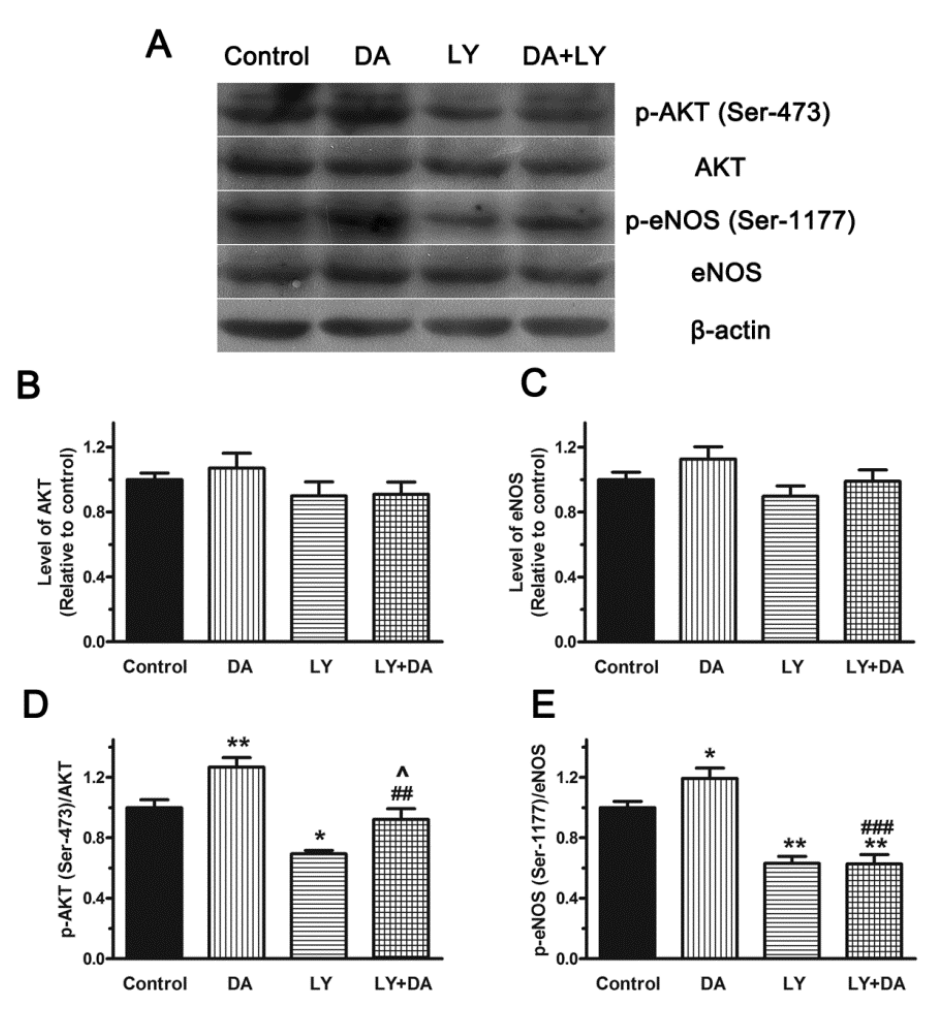
Figure 8. Role of the PI3K/Akt Pathway in DA -induced phosphorylation of AKT and eNOS in PAECs. PAECs were incubated with vehicle (DMSO), DA (20 μ M), LY294002 (LY, 10 − 6 M) and DA (20 μ M) plus LY (10 − 6 M) for 10 min. Then the levels of p-Akt (Ser-473), Akt, p-eNOS (Ser-1177) and eNOS ( A ) were determined by Western blot analysis. Results are presented as means ± SEM ( n = 3) ( B , C , D , E ). * p < 0.05 and ** p < 0.01 versus control. ## p < 0.01 and ### p < 0.001 compared to corresponding DA group. ^ p < 0.05 compared to corresponding LY